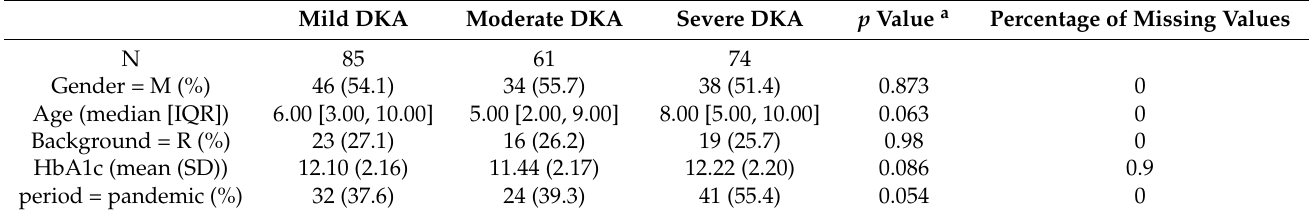
Table 4. Characteristics of the DKA subset, according to DKA severity.